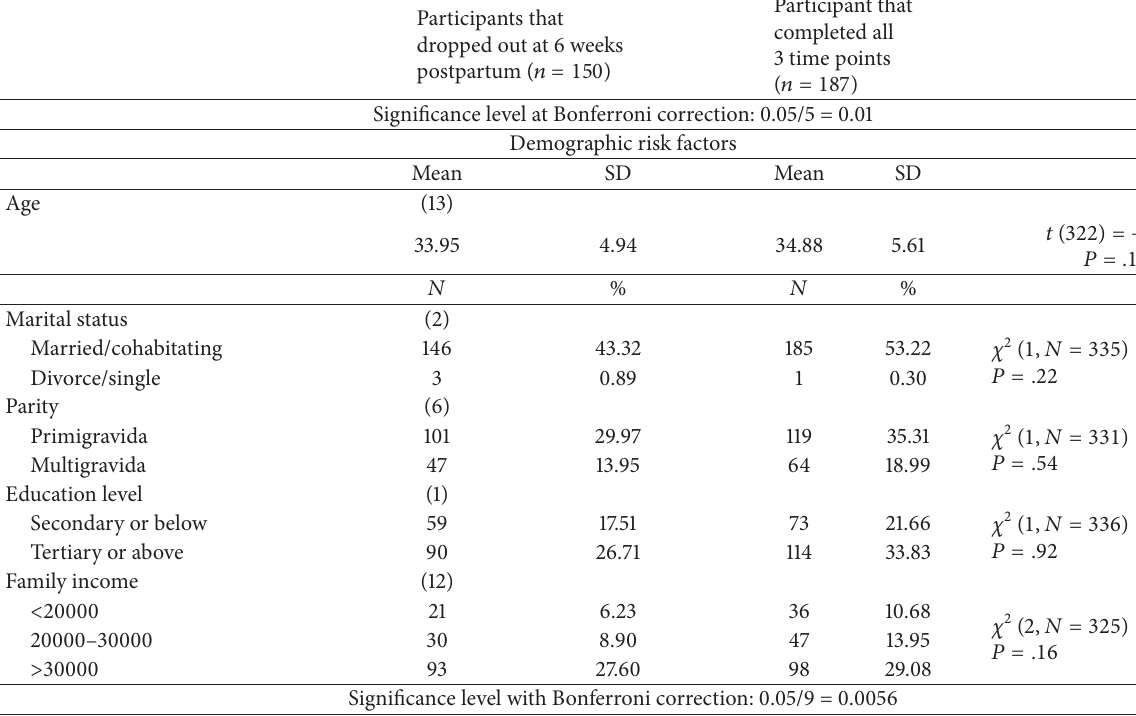
Table 2: Sample characteristics and attrition analysis of expectant fathers with comparison between fathers who completed all time points and fathers who dropped out at six weeks